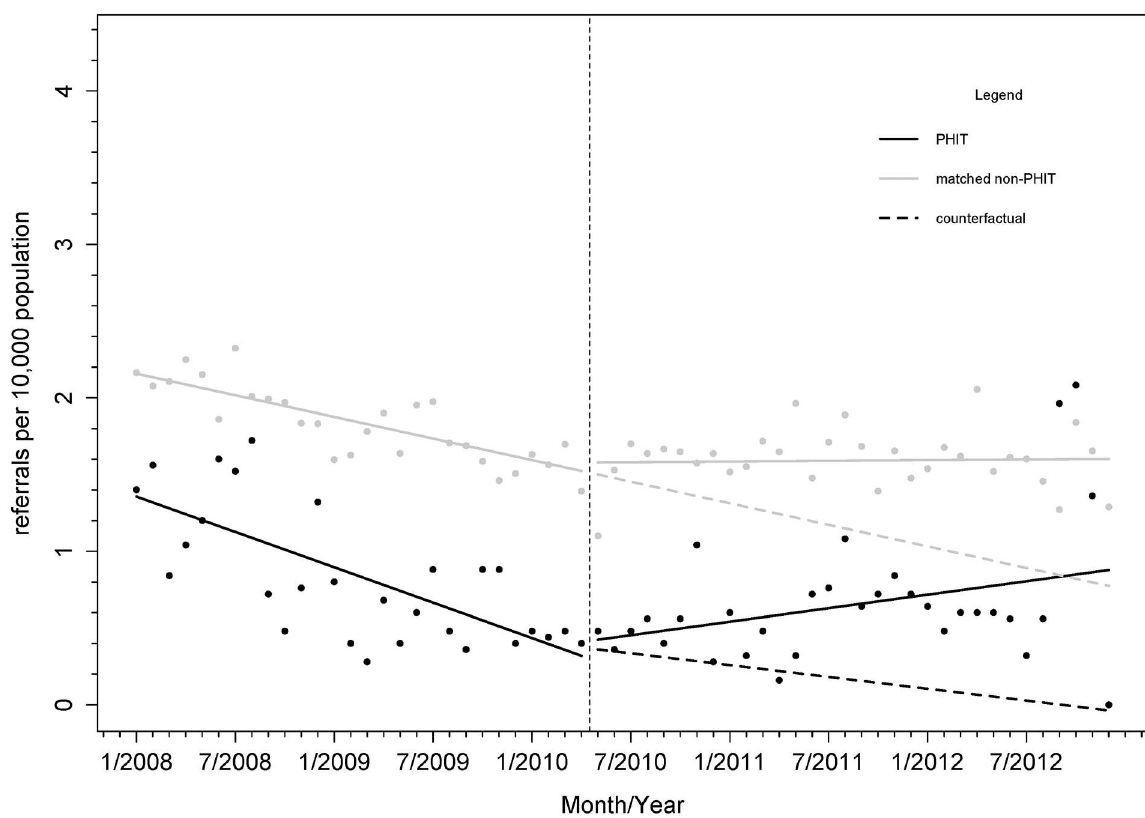
Fig 3. Monthly rates of referralfor high risk pregnancy (count per 10,000 women in the population) in PHIT health facilities (n = 13) or comparison propensity score matched facilities (n = 86). Notes: Vertical line indicatesstart of PHIT HSS intervention in May